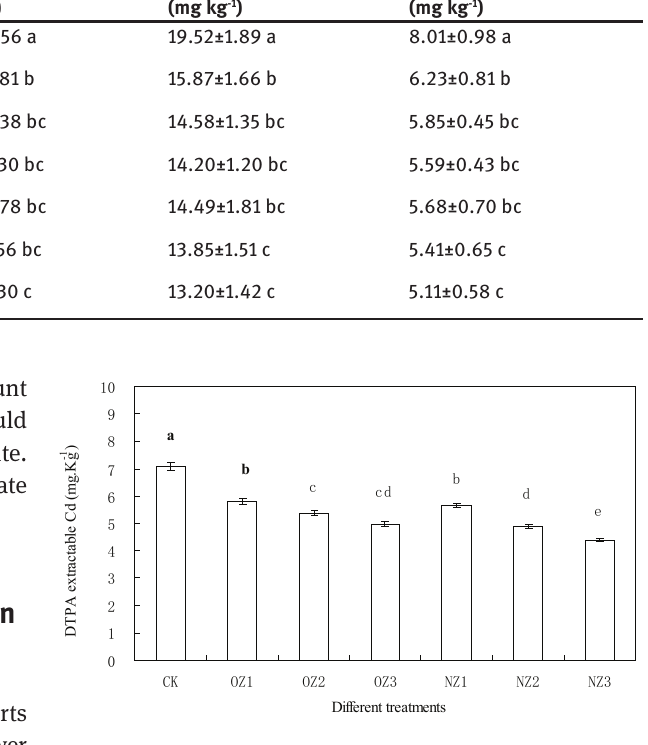
Figure 2: Effects of application of ordinary zeolite and nano zeolite on the content of available Cd in soil.